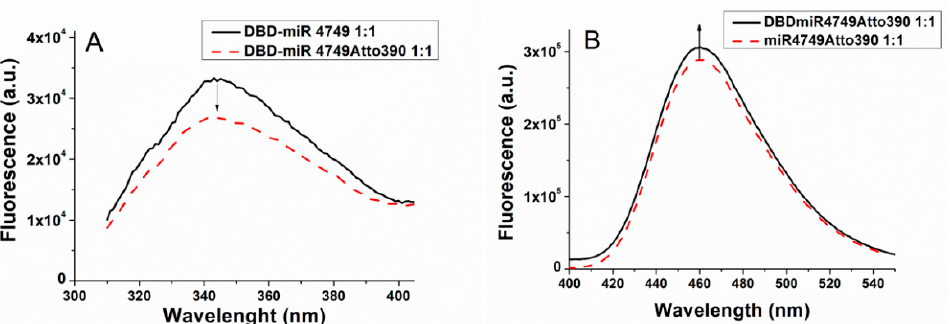
Figure 3. ( A ) Fluorescence emission spectra of DBD-miR4749 (black line) and of DBD-miR4749Atto390 (red dashed line), obtained at a concentration of 1 µ M with a 1:1 molar ratio between DBD and miR4749 or miR4749Atto390. ( B ) Fluorescence emission spectra of DBD-miR4749Atto390 (black line) at a concentration of 1 µ M and of miR4749Atto390 (red dashed line); both of them at a concentration of 1 µ M, with a 1:1 molar ratio. All the spectra were excited at 295 nm and corrected for the Raman scattering of the buffer.